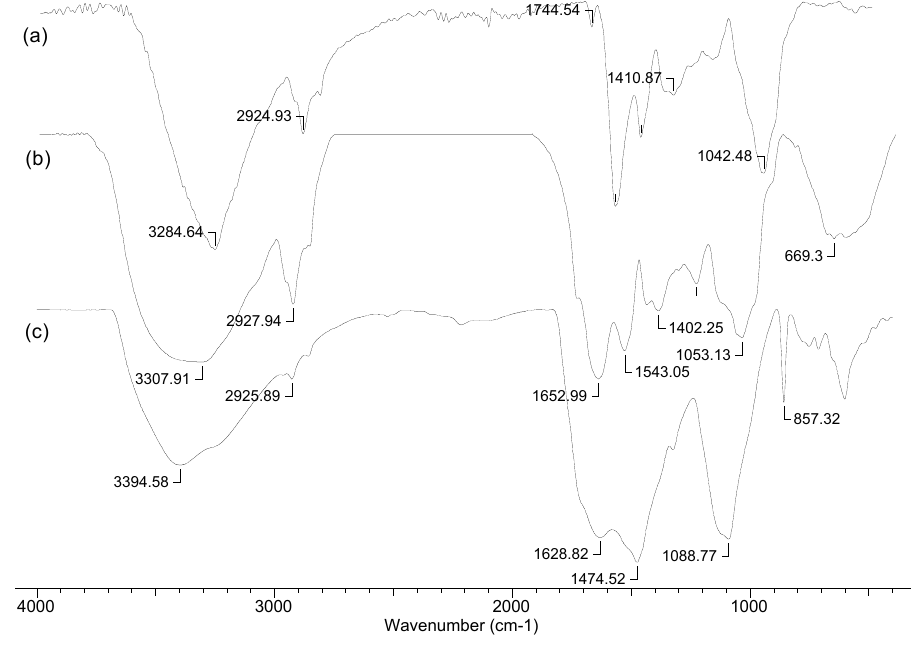
Figure 2. FTIR spectra of MBC (a), SBC ( b ), and ABC ( c ).